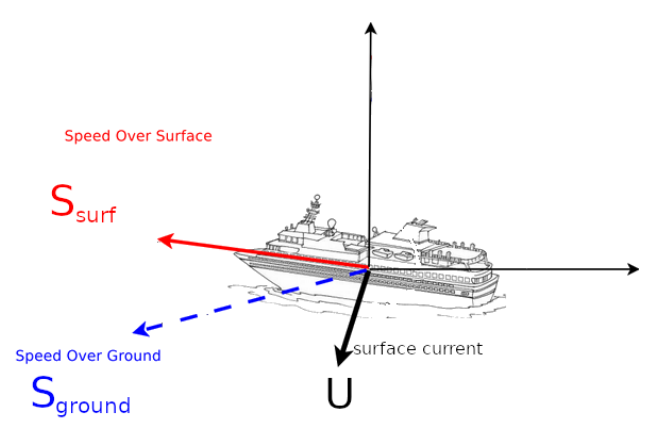
Figure 1. Observational model: Under ideal condition, the motion of a boat over the ground is modeled using a linear relation: speed over ground = Speed on surface + current . This assumption is no more valid in presence of external forcing (for example in stormy conditions).